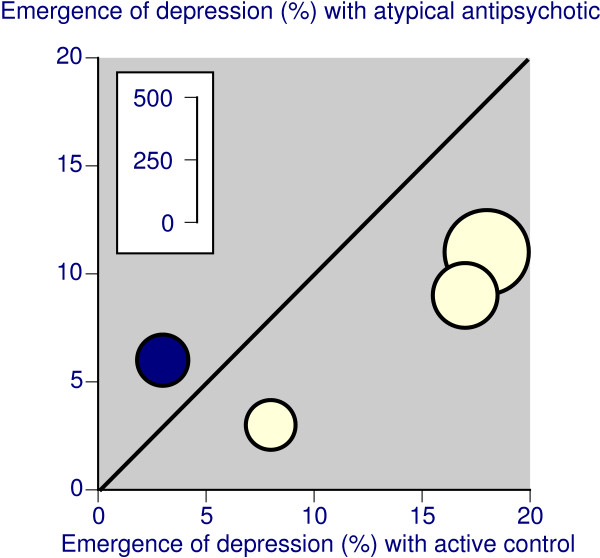
Emergence of depression with atypical antipsychotic or active comparator in placebo-controlled trials lasting 6–12 weeks, where the presenting episode was mania or mixed. The dark symbol indicates lithium as the comparator, and the light symbols haloperidol. The inset scale relates the number of patients in the comparison.